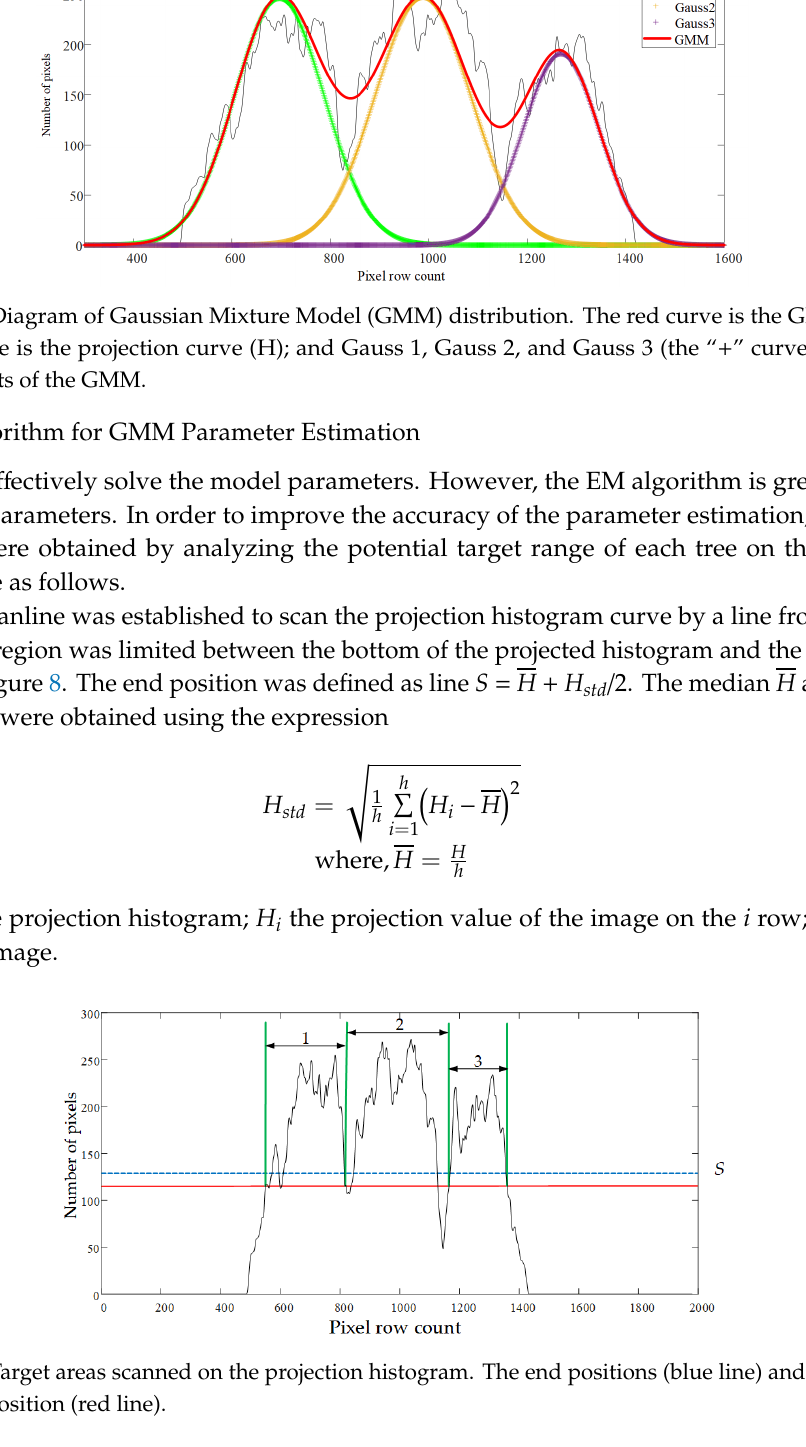
(2) To identify the target region, the intersections of the scan line and the projection curve were